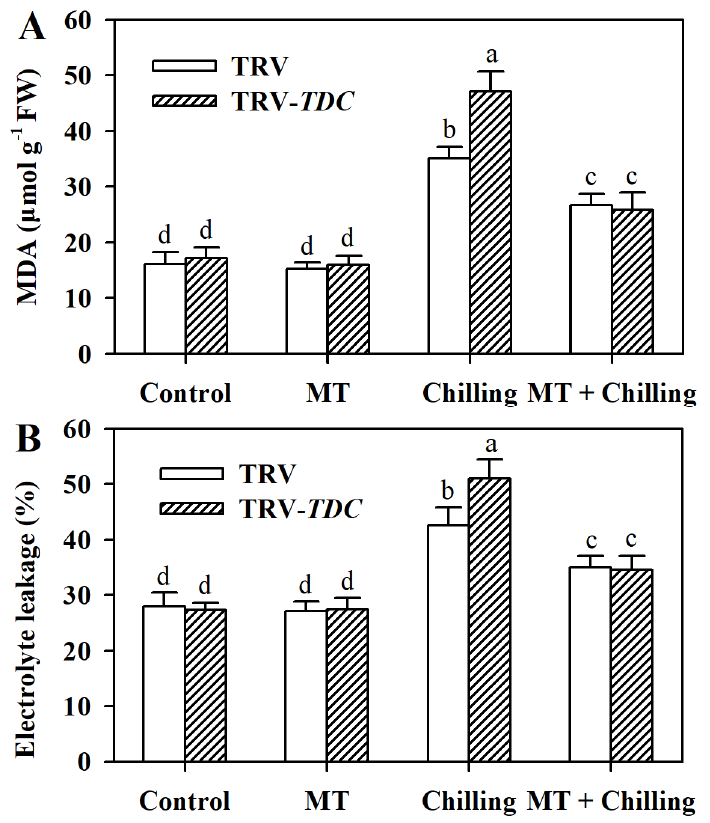
Figure 4. Lipid peroxidation and membrane stability as a ff ected by TDC silencing and exogenous melatonin in tomato leaves under chilling stress. ( A ) MDA content; ( B ) electrolyte leakage. Tomato plants at the 6-leaf stage were exposed to chilling stress (4 ◦ C) for 12 h and leaf samples were collected for the determination of MDA and electrolyte leakage. The values presented are means ± SDs ( n = 3). Di ff erent letters (a–d) above bars indicate significant di ff erence at p < 0.05 among treatments.